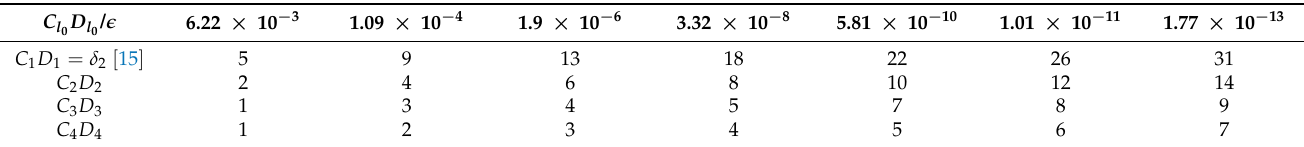
Table 8. Depth of a 4 -point interpolating QSS surface